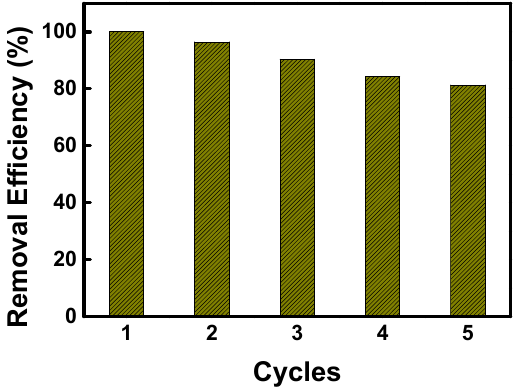
Figure 5. Reusability of SPAC-8 for the adsorption of MB.